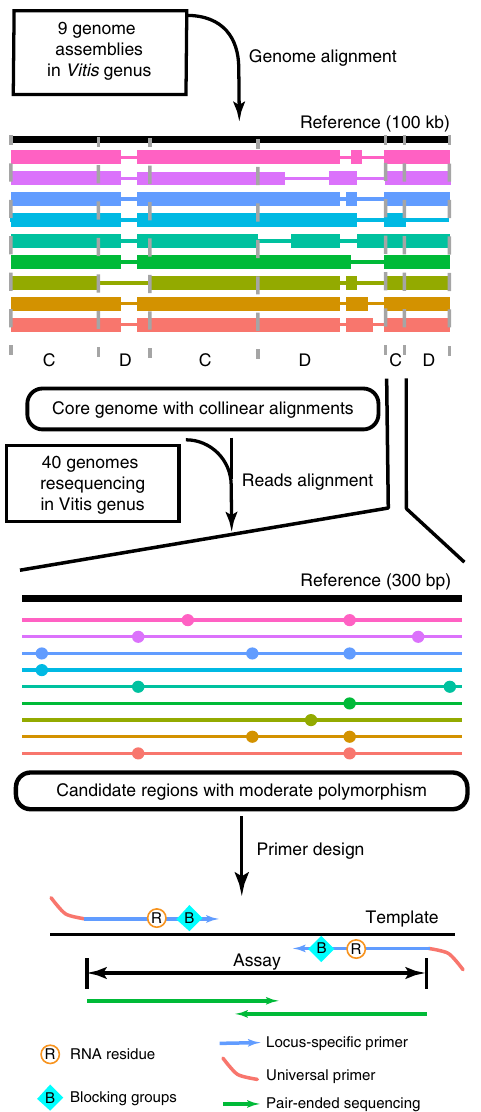
Fig. 2 Marker design pipeline based on genus-wide core genome and polymorphism. Colored blocks, alignment between the query genome and the reference genome. C, core genome; D, dispensable genome. Colored dots denote genomic variants. In the rhPCR, an RNA residue and several bases of blocking DNA are added to the allele-speci fi c primer. The RNA residue together with the blocking DNA can only be cleaved by the RNase H2 enzyme when the match between the target and the primer is perfect. After the RNA residue and the blocking DNA are removed from the 3 ′ end, the extension reaction will